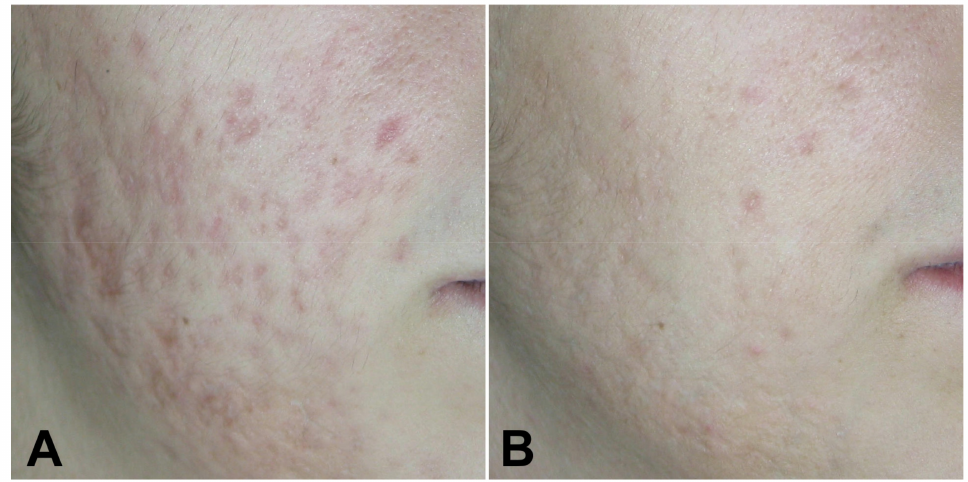
Figure 1. Patient 14 before ( A ) and 3 months after ( B )